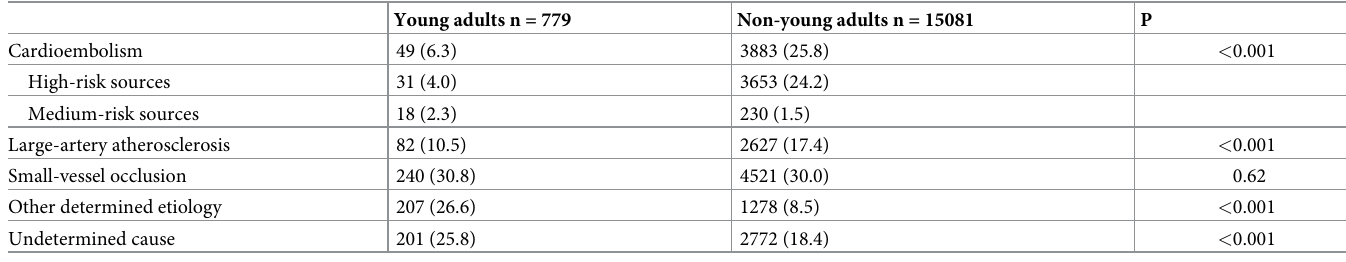
Table 2. Stroke subtype of young adults and non-young